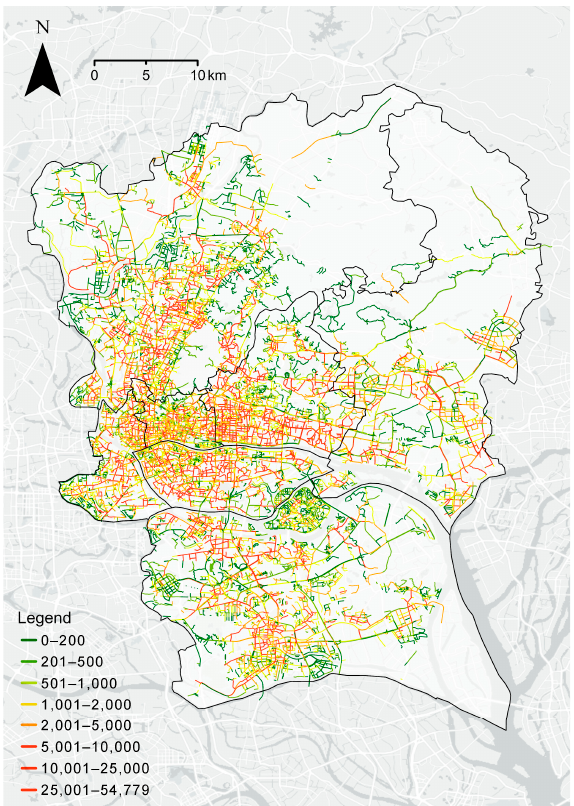
Figure 11. Path and number of females on the path from their residence and work to public transport stops. Map data sources: (c) OpenStreetMap contributors.